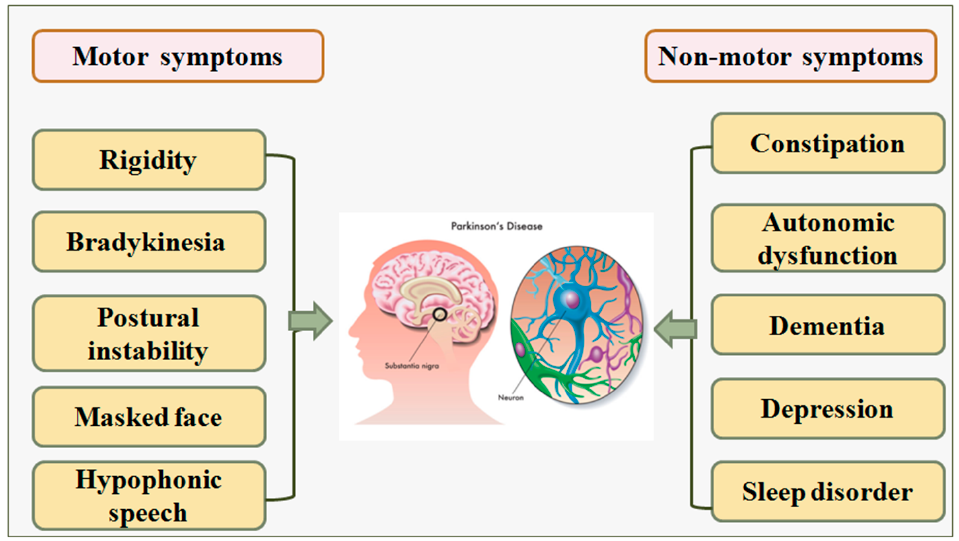
Figure 7. Symptomatic biology of